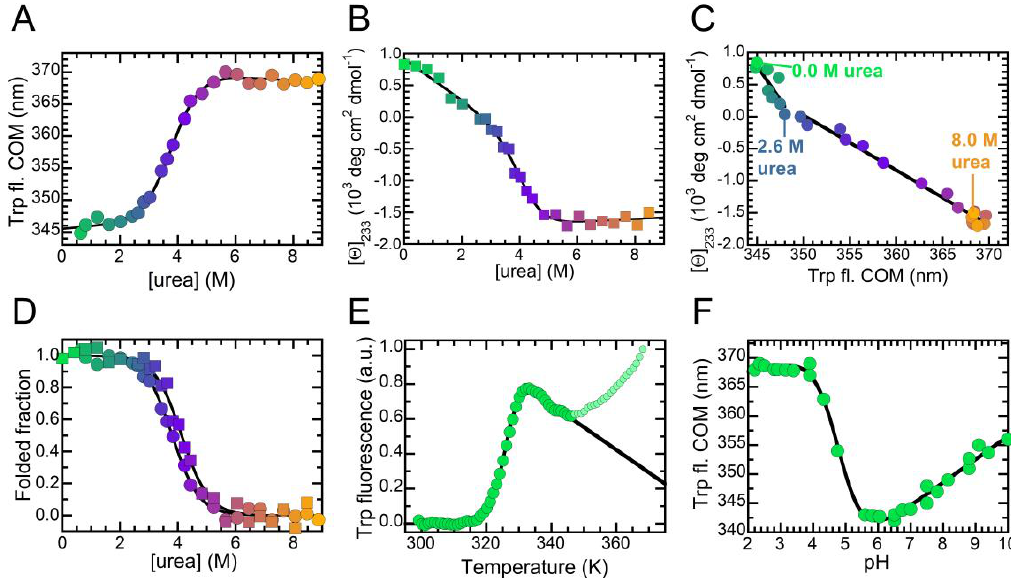
Figure 4. Conformational stability of NTD investigated by means of di ff erent spectroscopic probes. In all panels color ranges from green to orange as urea concentration increases from 0 to 8.4 M. ( A ) Urea-induced denaturation curve monitored by tryptophan fluorescence, reported as COM. The continuous line represents the best fit to a two-state model. ( B ) Urea-induced denaturation curve monitored by mean residue ellipticity at 233 nm. The continuous line represents the best fit to a two-state model. ( C ) Phase diagram illustrating tryptophan fluorescence (from panel A ) plotted vs. CD signal at 233 nm (from panel B ). Black lines highlight transitions among the conformational states detected at 0, 2.6 and 8.0 M urea. ( D ) Folded fraction as a function of urea concentration, calculated using data from panel A (circles) and B (squares). The continuous line represents the best fit to a two-state model. ( E ) Thermal denaturation monitored by means of DSF. The continuous line represents the best fit to the equation described in the Methods section. Pale green points were not included in the analysis. ( F ) pH-induced denaturation monitored by tryptophan fluorescence. The continuous line represents an arbitrary spline function.